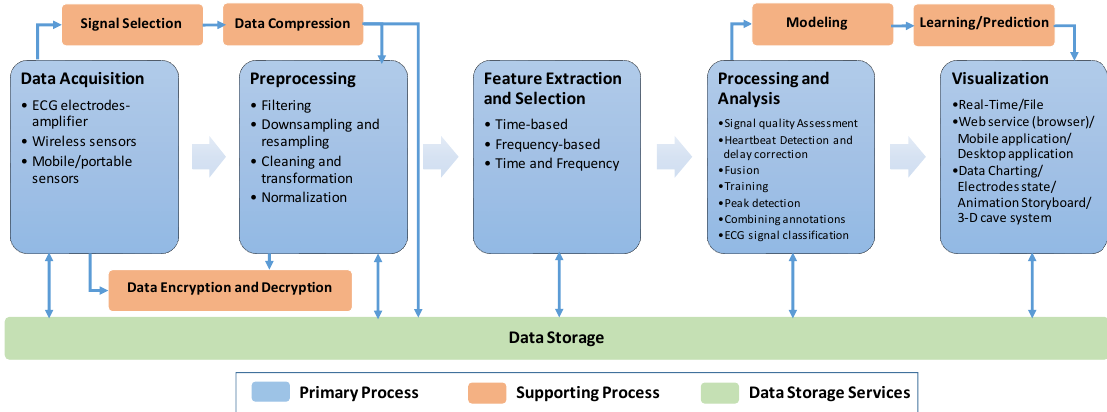
Figure 2. ECG Monitoring Lifecycle.